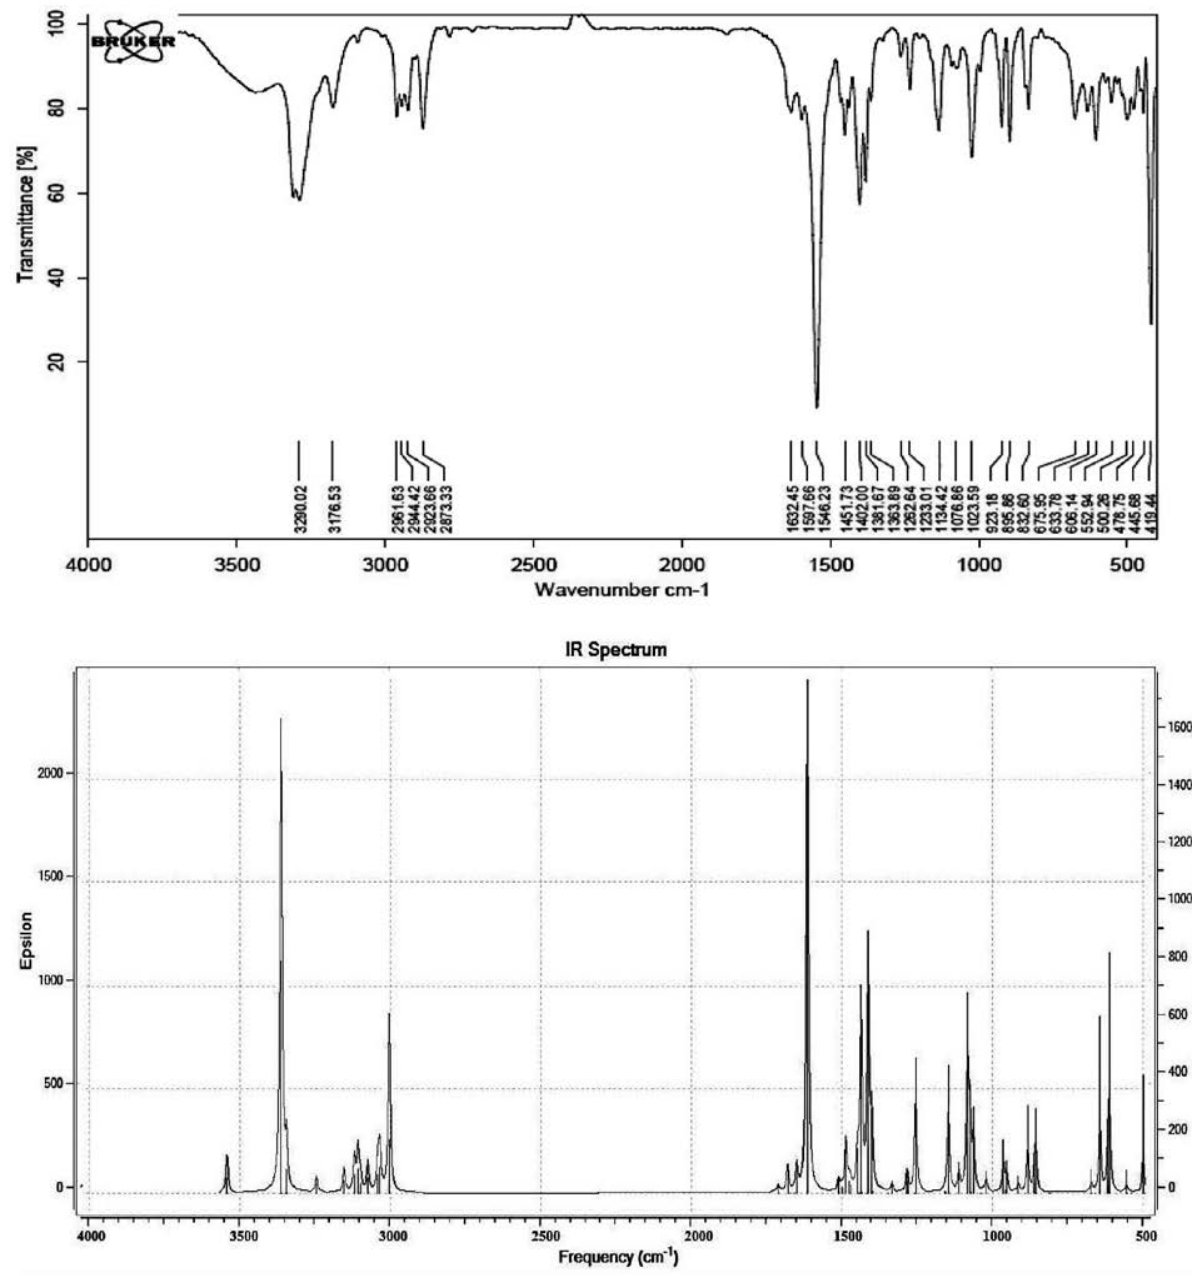
Fig. 6. The experimental (top) and calculated (down) IR spectra of complex 2